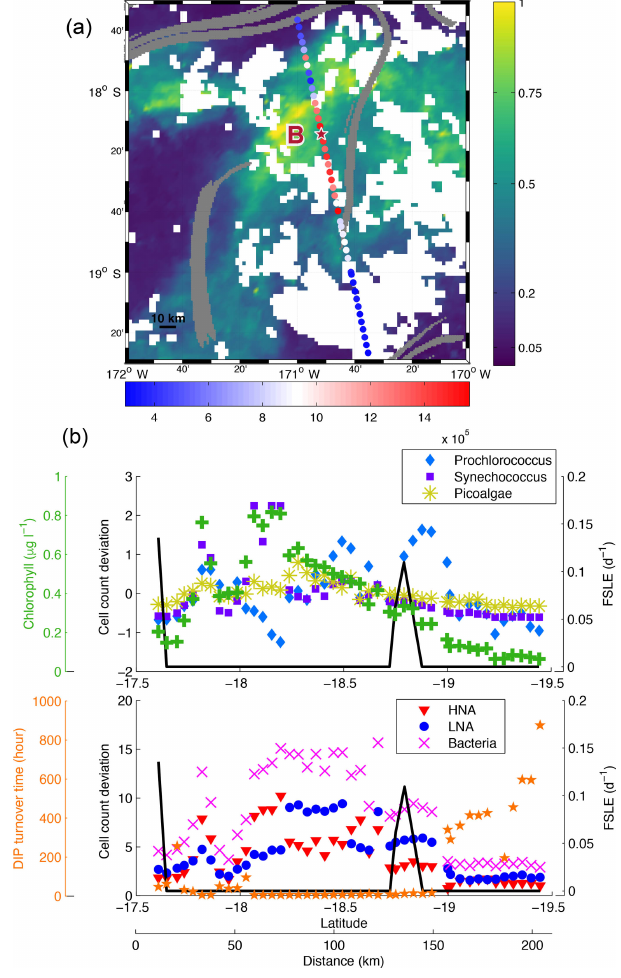
Figure 7. (a) Chlorophyll concentration (mgm − 3 , colour bar) from 13 March 2015 superimposed with bacteria counts (cellmL − 1 , red-blue colour bar) sampled during LDB. FSLE fronts (val- ues > 0.05day − 1 ) are shown in grey. The location of LDB is indi- cated with the red star. White squares are missing satellite data due to cloud cover. (b) Cell count deviation (see Sect. 2.1) of Prochloro- coccus , Synechococcus , PPEs and bacteria (HNA and LNA) super- imposed with FSLE (day − 1 , black line), surface chlorophyll con- centration (µgL − 1 , green crosses) and dissolved inorganic phos- phate turnover time (hours, orange stars) along the high-frequency transect of